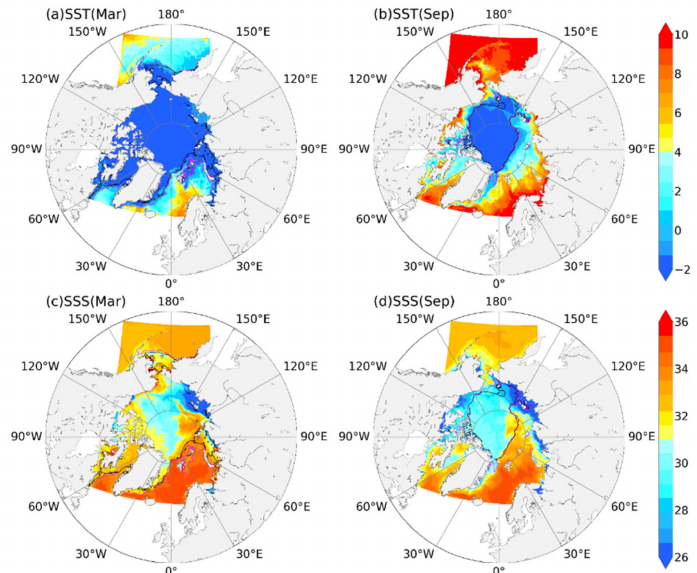
Figure 8. Distribution of sea surface temperature in March ( a ) and September ( b ) for the Ctrl experiment. ( c , d ) Same as ( a , b ), but for sea surface salinity. The magenta line and black line in ( a – d ) indicate the sea ice concentration of 15% and 80% in the Ctrl experiment, respectively.